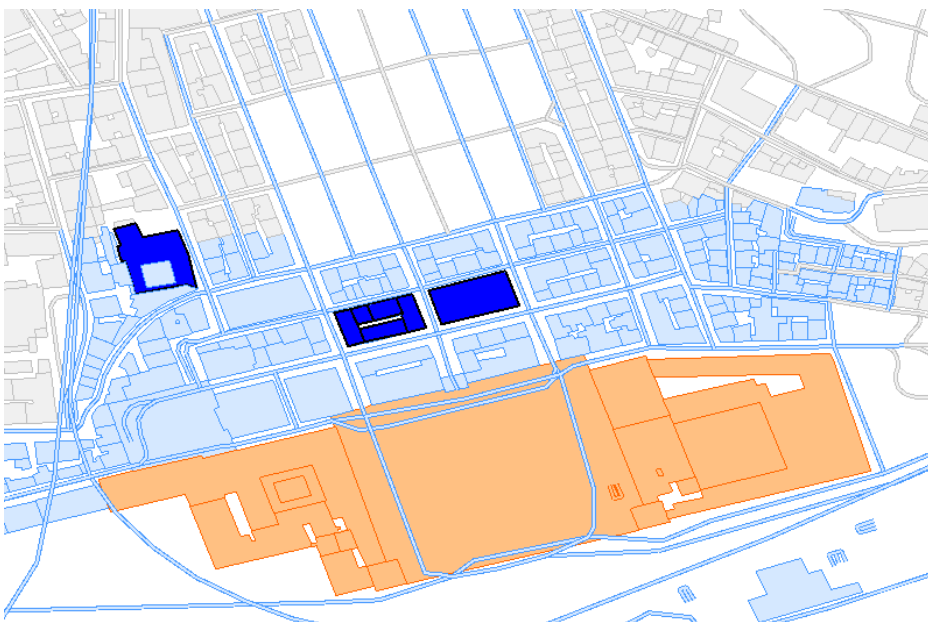
Figure 3. Classification of Parcels. Example of a map composed of parcels that can be classified according to land use